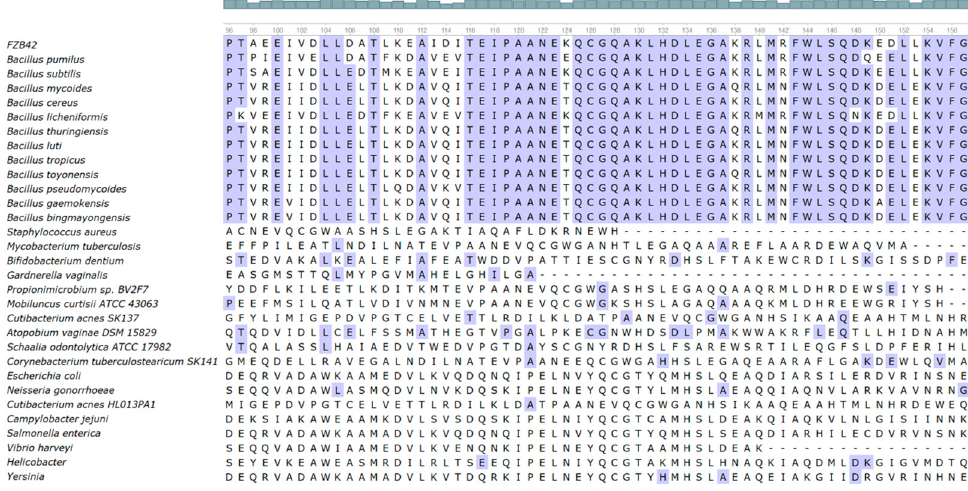
Figure 8. Alignment of the amino acid sequences of LuxS from different bacteria.